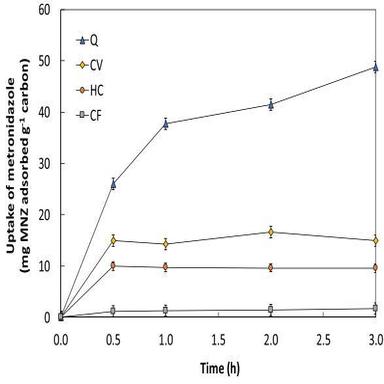
Adsorption capacity of metronidazole on the carbon materials used as cathodes (ca. 0.150 L, 100 mg L-1 metronidazole, 50 mM Na2SO4, pH 3).